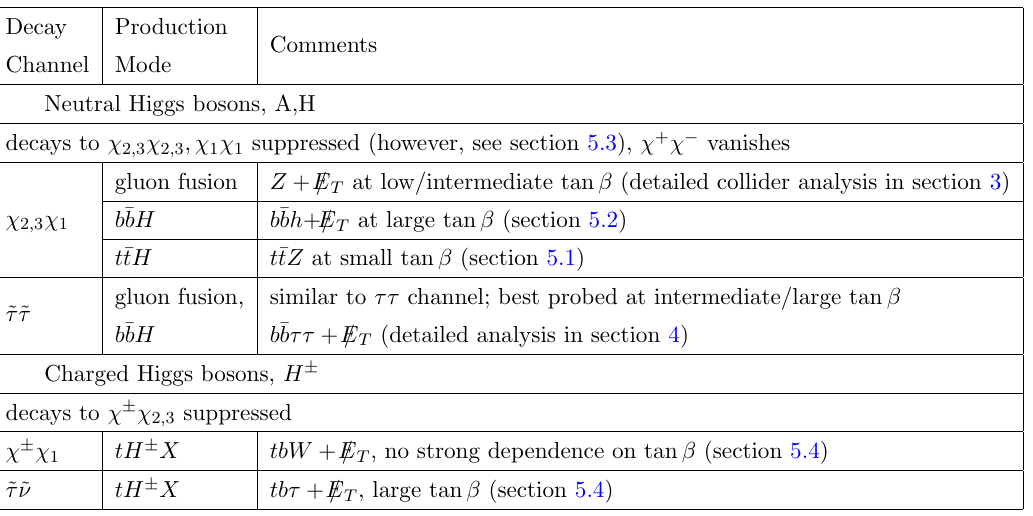
Table 2 . Summary of heavy Higgs boson decay channels and HL-LHC prospects discussed in this work for scenarios with light binos-Higgsinos, or light staus. Here, \suppressed" implies suppression of the vertex from the bino-Higgsino mixing